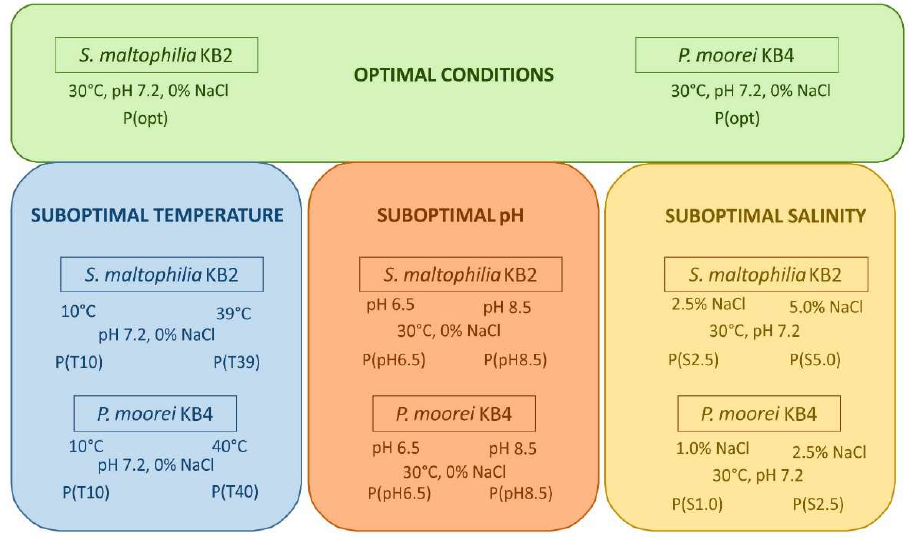
Figure 1. Conditions of bacteria cultures in optimal and suboptimal temperatures, pH, and salinity.